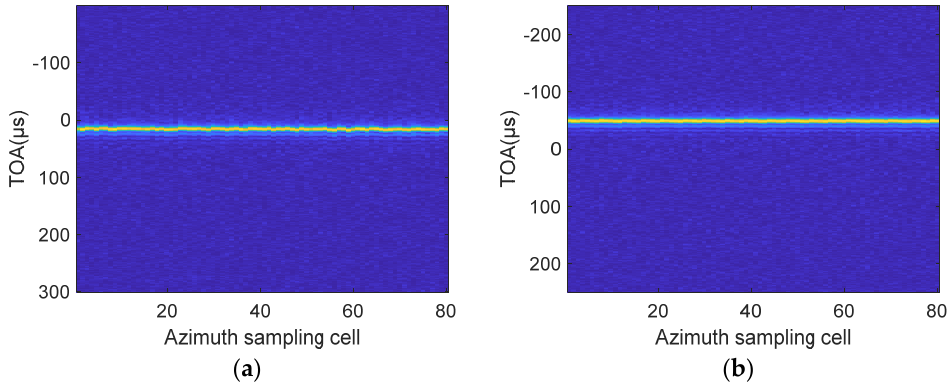
Figure 14. TOAs of two receivers after the RCM correction. ( a ) Receiver #1, ( b ) Receiver #2. The azimuth Fourier transform completes the azimuth compression. The TOA and Doppler frequency of each receiver is then obtained, as shown in Figure 15. The data are well compressed. The TOA of Receiver #1 is 17.000 μ s and the Doppler frequency is 7683.000 Hz. The TOA is − 33.000 μ s and the Doppler frequency is 2733.000 Hz for Receiver #2.